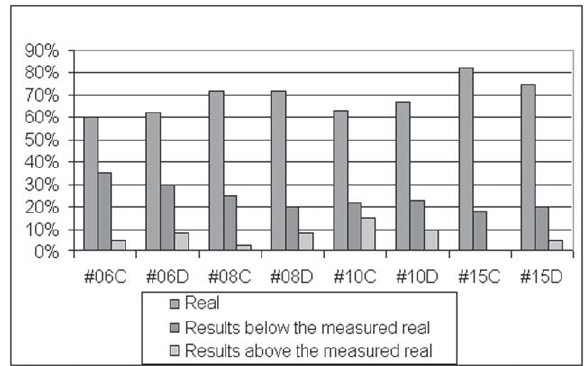
FIGURE 1- Values of the method obtained from conventional (C) and digital (D) radiographs and files #06, #08, #10